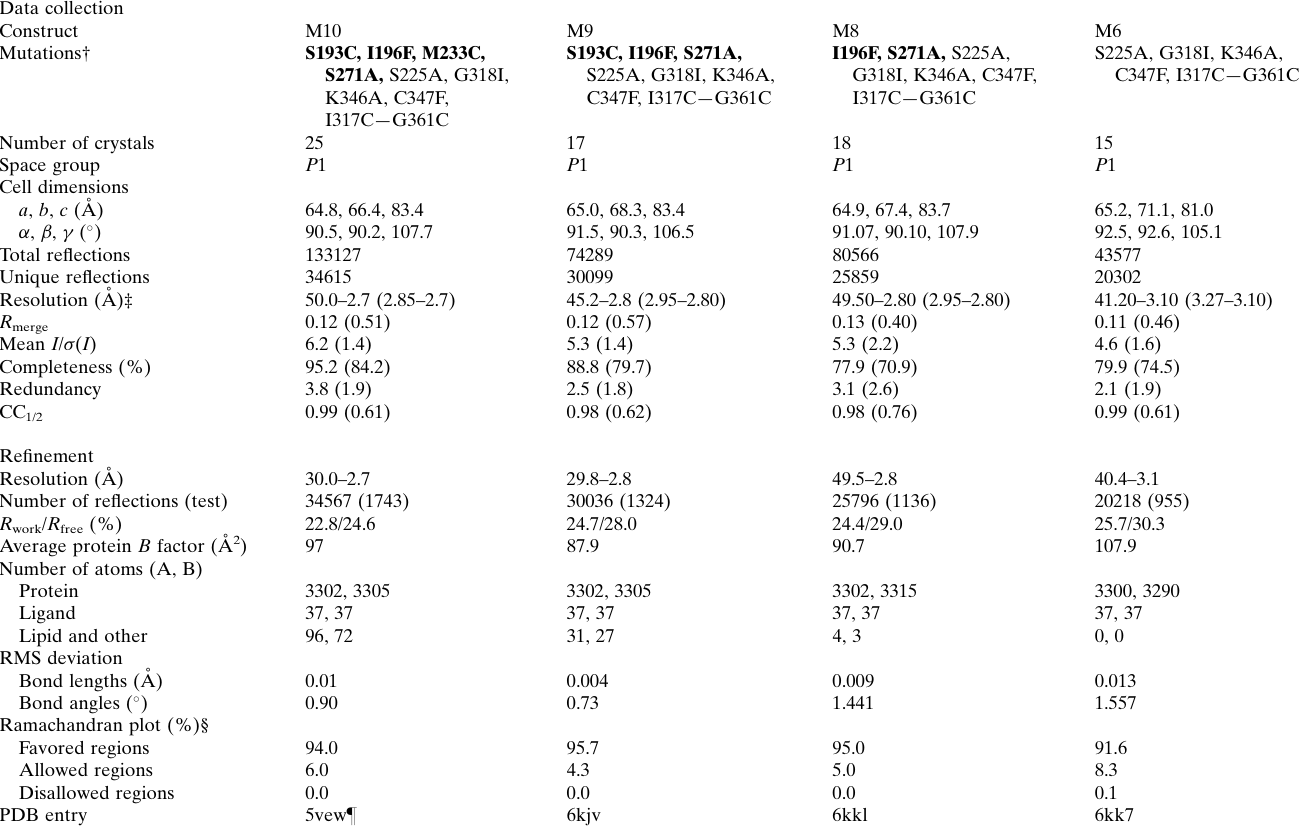
Table 1 Data-collection and refinement statistics of GLP-1R